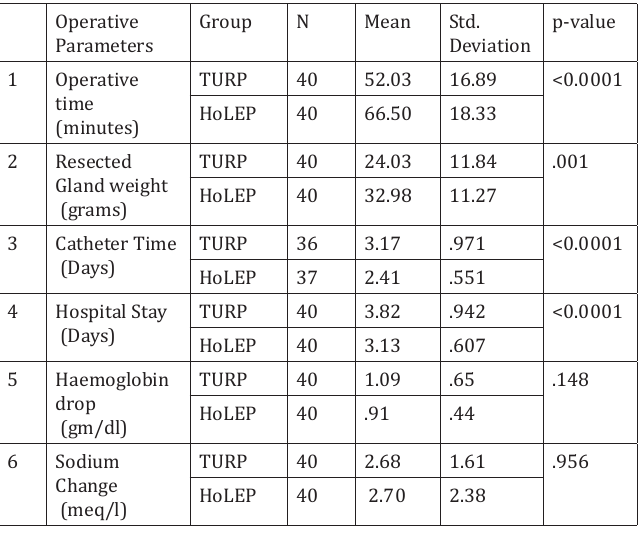
Comparision of operative and post operative parameters in both study groups